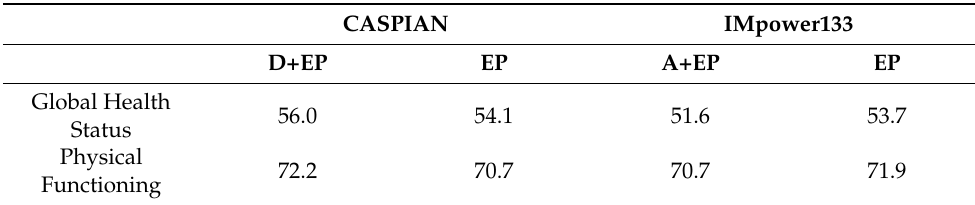
Table 3. Baseline HRQoL Scores from CASPIAN and IMpower133. D+EP, durvalumab and etoposide platinum; EP, etoposide platinum; A+EP, atezolizumab and etoposide platinum.